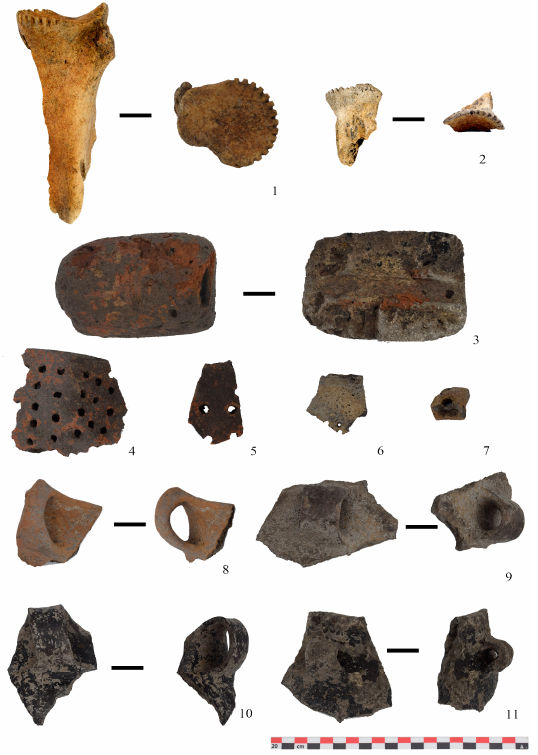
Figure 2. Archaeological materials discovered on the ashmounds’ surfaces during the fieldwalks from B ă deni– Dealul Moara de Vânt (Ia ș i County): 1,2—crenated scapulae , 3—fragment of loom weight, 4–7—ceramic fragments of smoke-vessels, 8,10—fragments of kantharos vessels, 9,11—ce- ramic fragments belonging to